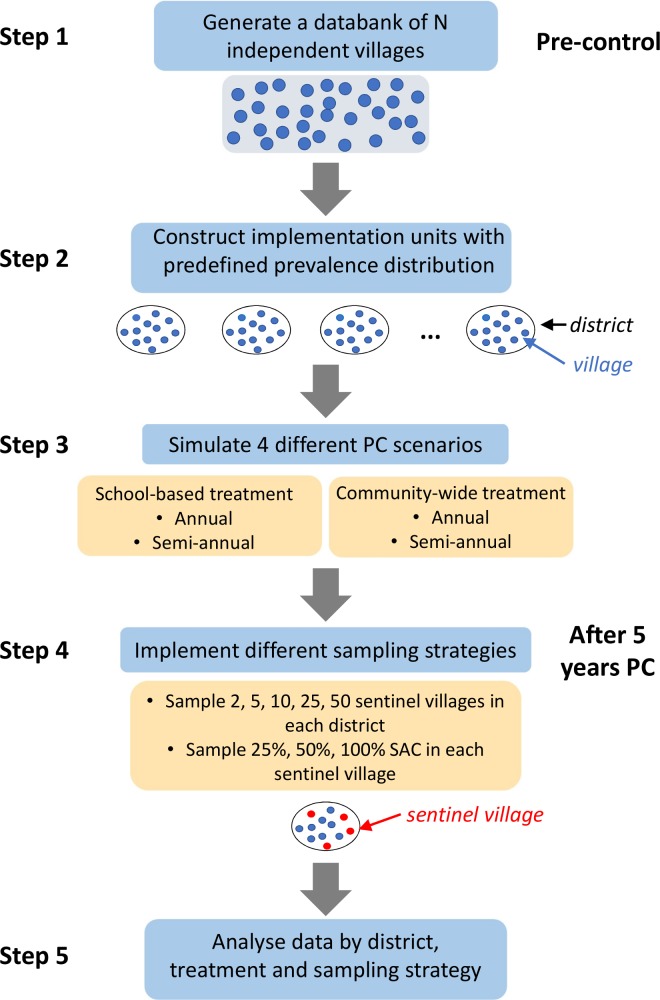
Flowchart describing the different steps of the simulation approach.First, each of the two models was used to generate a databank of simulations (step 1). Each simulation with a (closed) population size of about 500 individuals can realistically represent transmission within a village. In step 2, implementation units are simulated sampling villages according to a predefined prevalence distribution according to Eq (1). The models are then used to simulate the impact of 4 different PC strategies on prevalence and intensity of infection (step 3). In step 4 (post-control) we consider 4 different sampling strategies and in step 5 we analyse the results by district, PC and sampling strategy.